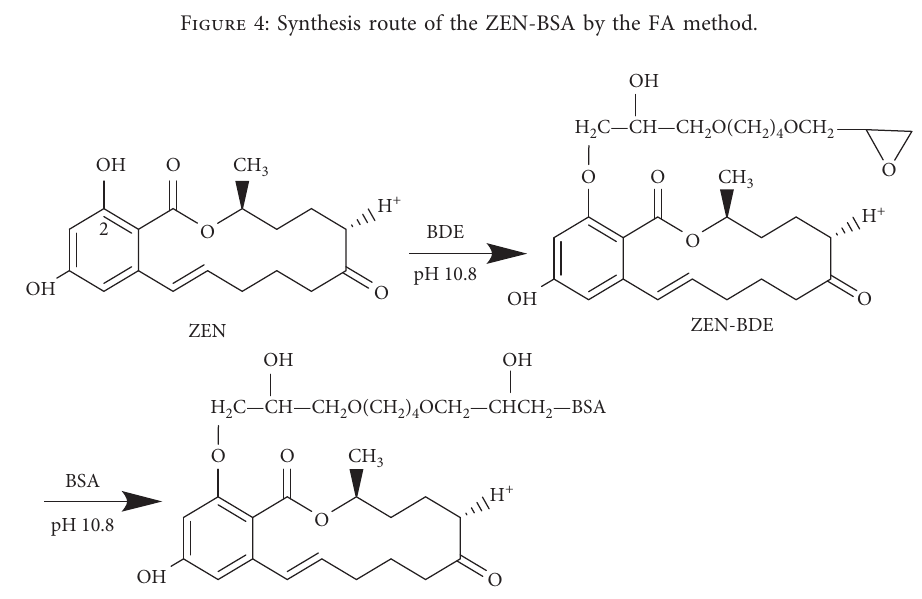
Figure 5: Synthesis route of the ZEN-BSA by the BDE method.